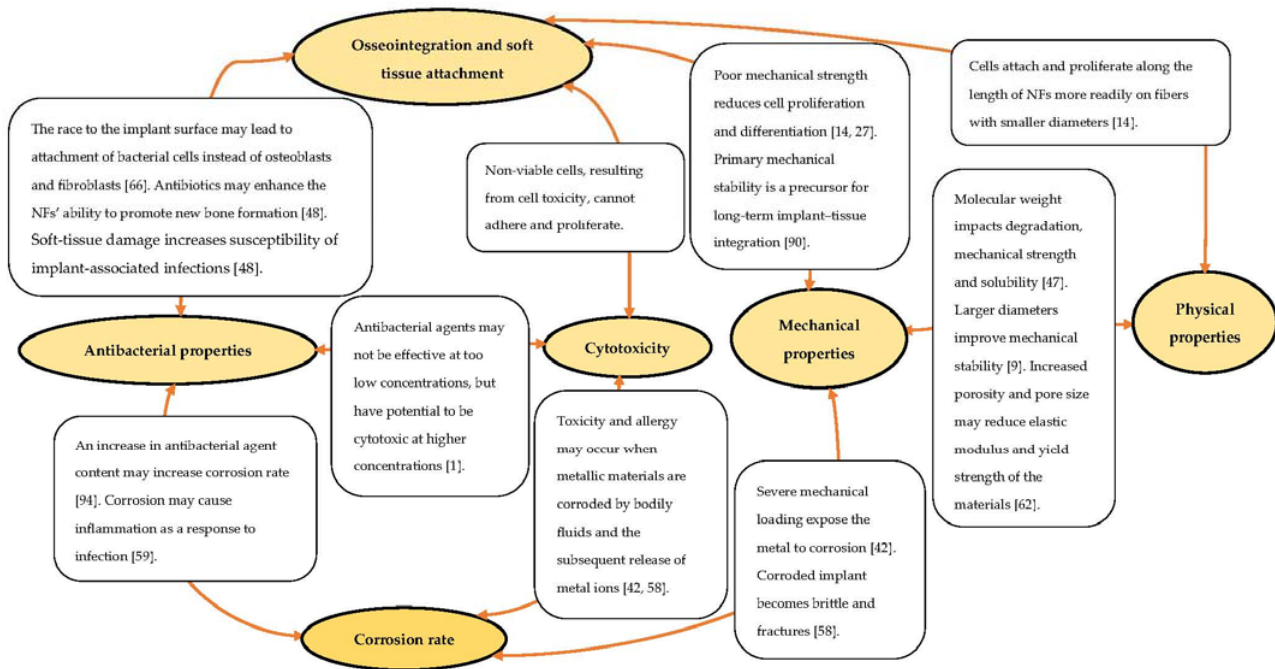
Figure 4. Correlation of the various aspects relatable to implantation failure.